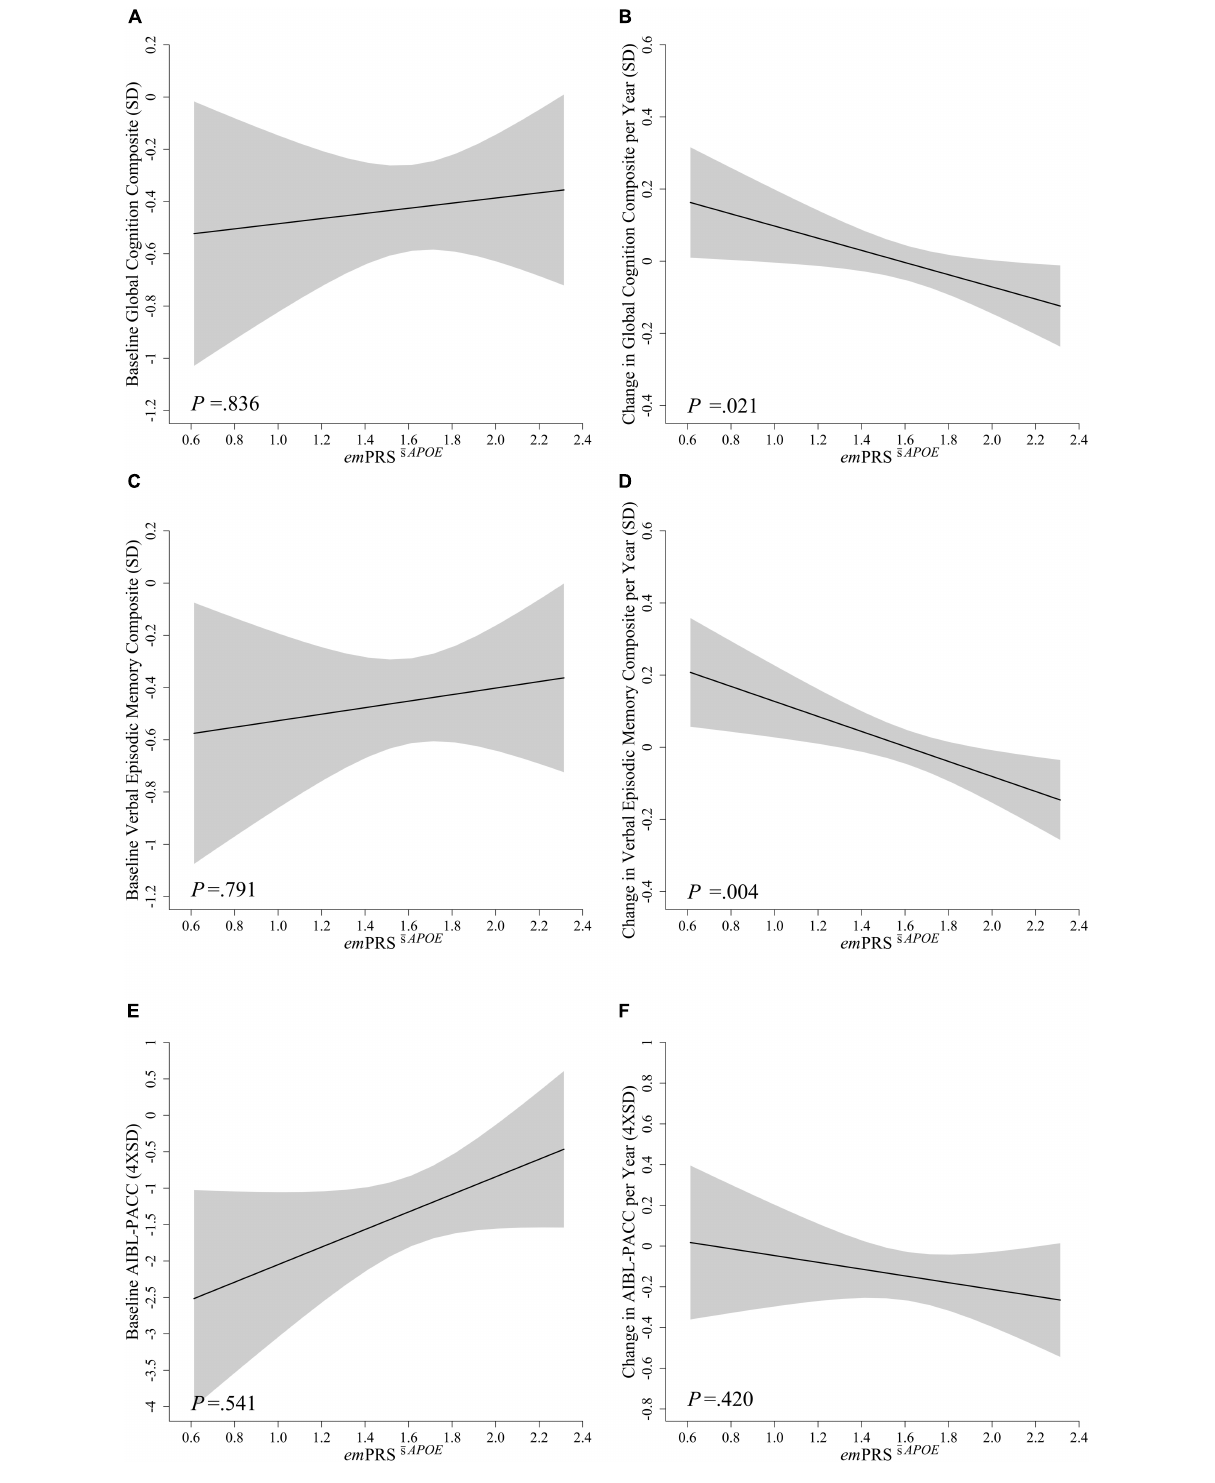
Frontiers in Aging Neuroscience |